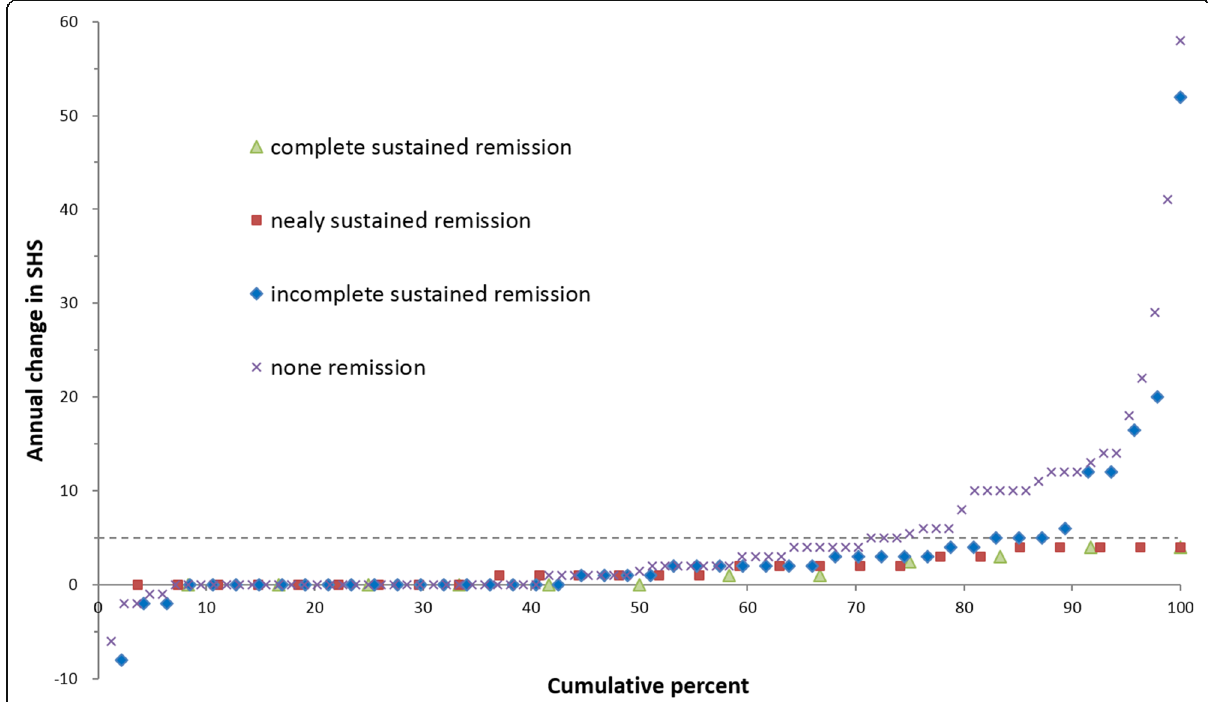
Fig. 3 Cumulative probability plot for patients in sustained remission according to SDAI criterion during follow-up period